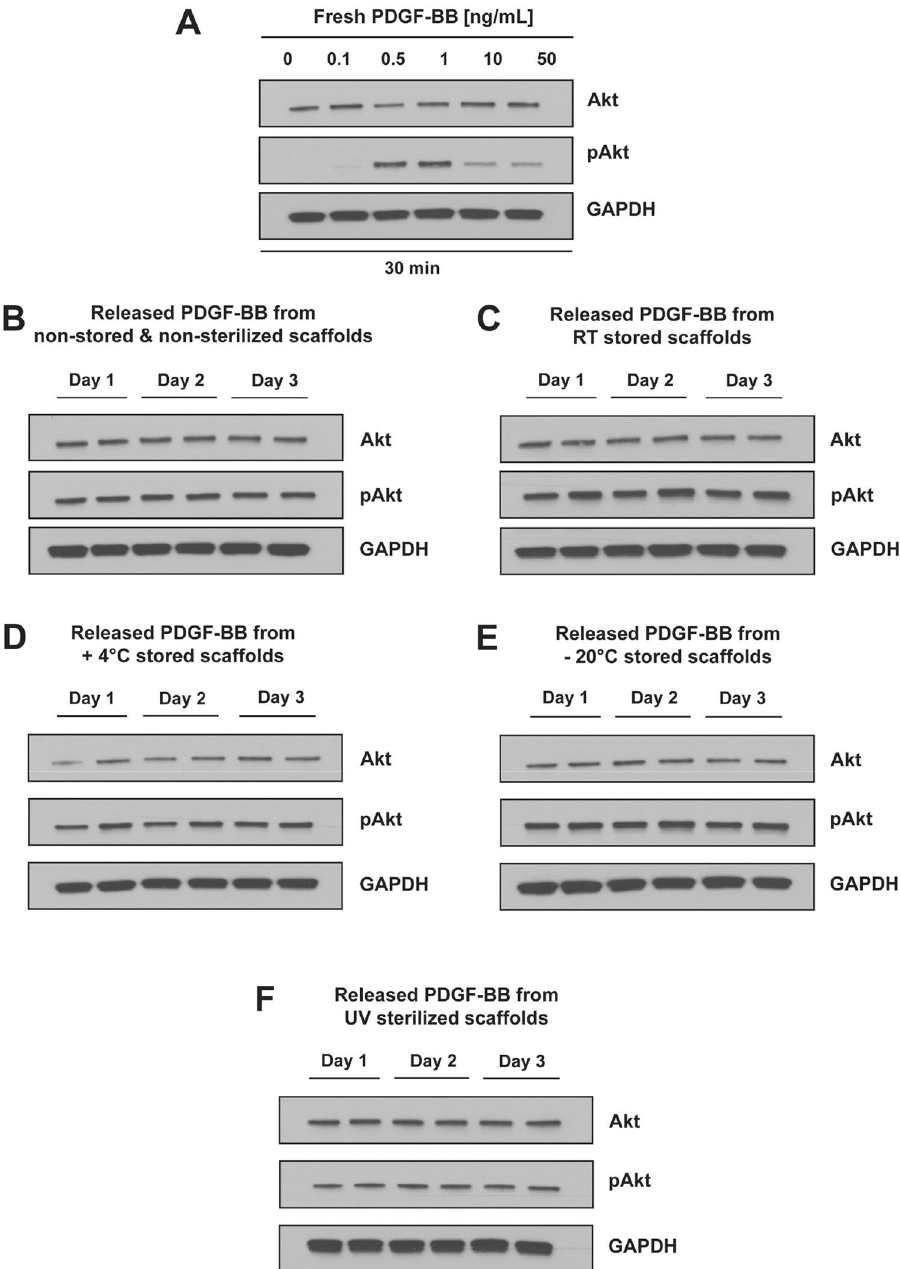
Figure 4. Bioactivity of released PDGF-BB from differently stored and UV sterilized bioactive DP scaffolds by Akt activation. ( A ) The phosphorylation status of Akt (pAkt) to dose-dependent PDGF-BB (0, 0.1, 0.5, 1, 10 and 50 ng/mL) supplementation (cells treated for 30 min) was analyzed by western blot. Presence of band for pAkt signifies phosphorylation of Akt and with that the ability of PDGF-BB to activate the PDGFR/PI3K/ Akt pathway. The phosphorylation status of Akt (pAkt) to PDGF-BB released from ( B ) non-stored and non- sterilized DP scaffolds, ( C ) scaffolds stored for 1 week at room temperature (RT) or D) 4 °C or ( E ) − 20 °C or ( F ) not stored but UV sterilized for 30 min. The release was performed in serum-free medium with 0.1% BSA and release samples for Day 1, 2 and 3 were tested (in duplicates), in order to obtain initial idea whether bioactivity of PDGF-BB is preserved after the specific treatments. Activation of Akt signaling pathway by released PDGF-BB, thus leading to increase in pAkt, shows retained bioactivity of the growth factor after the specific storage time period or the UV sterilization. For uncropped images, we refer to Fig.